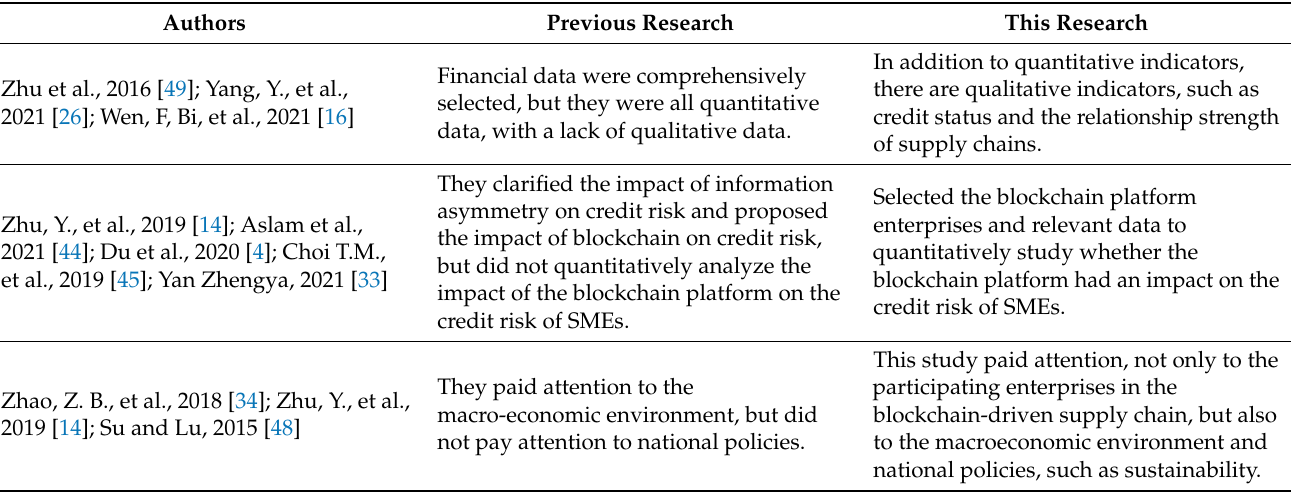
Table 1. Comparison between previous research and this